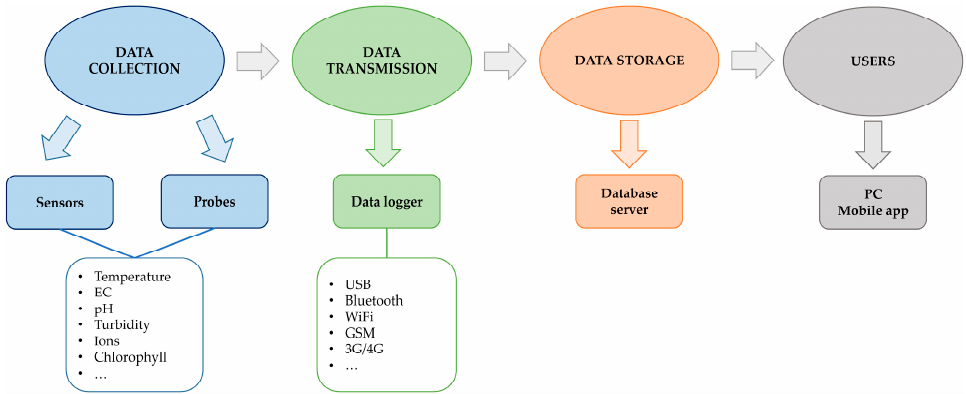
Figure 1. Scheme of automated continuous WQM.